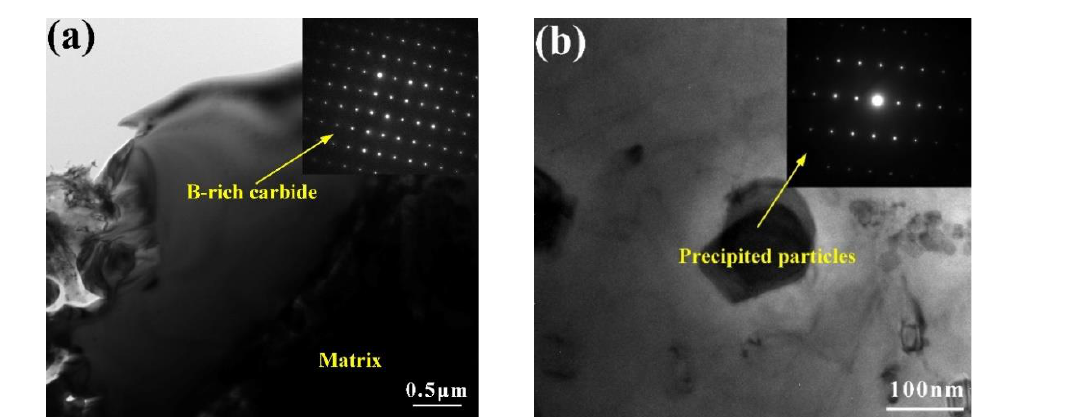
Figure 9. Microstructure of boron-bearing high-speed alloy steel after tempering: OM results ( a ), SEM results ( c ) and SEM results at high magnification ( e ) of alloy A; OM results ( b ), SEM results ( d ) and SEM results at high magnification ( f ) of alloy B.